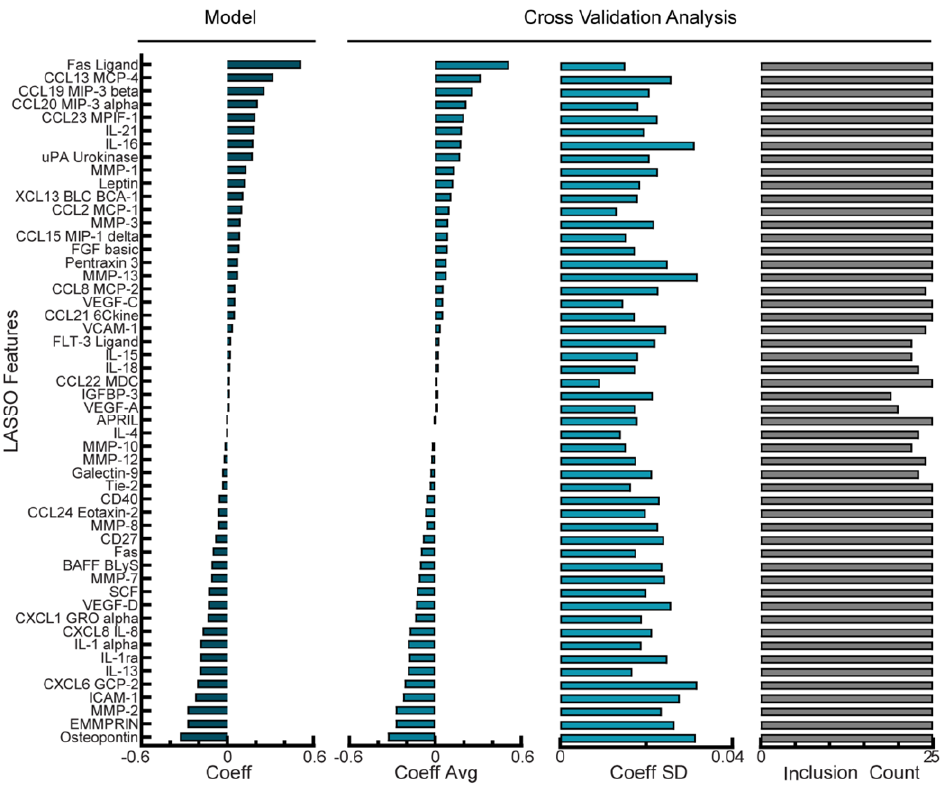
Figure 2. Regularized regression predicts PFI from analyte levels in ascites of NACT cohort. Co- efficient for each analyte feature in the optimal Lasso model trained on all NACT patients. Cross- validation analysis includes average and standard deviation of coefficient values and the number of times each analyte was given a non-zero coefficient value across leave-one-out cross-validation folds in the optimal NACT model. Positive coefficients correspond to longer